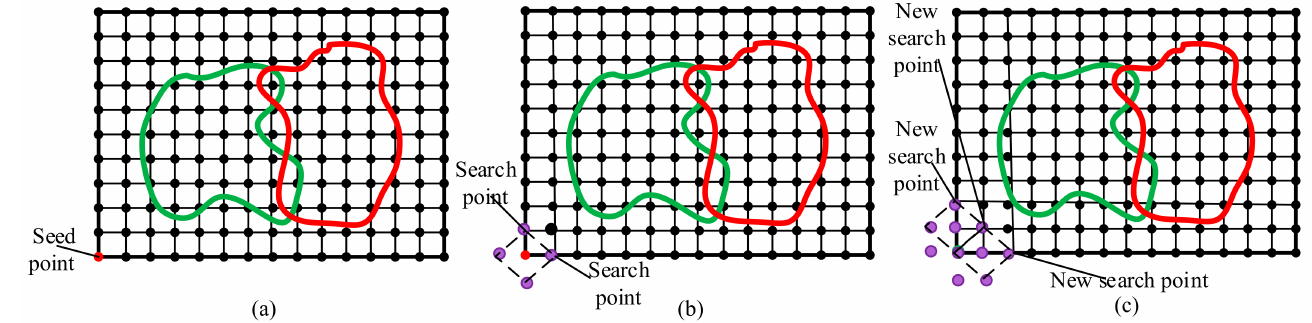
Figure 6. Strategy for obtaining the search points. ( a ) Obtain the seed point. ( b ) Obtain the adjacent points of the seed point and find search points. ( c ) Obtain the adjacent points of each search point and find new search